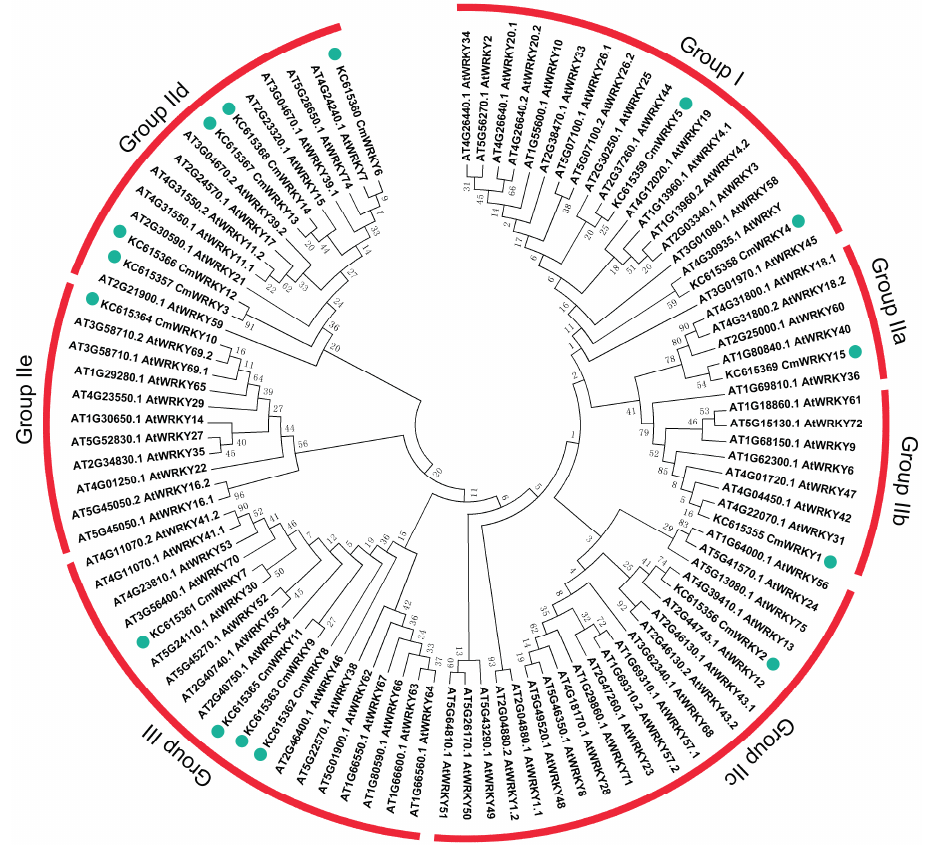
Figure 1. An unrooted phylogenetic tree of the WRKY peptide sequences of chrysanthemum and A. thaliana . Sequences were aligned using ClustalW and the phylogeny constructed using the neighbor-joining method. The red arcs indicate the various groups (and subgroups) defined by the presence/absence of known WRKY domains. Dots indicate likely